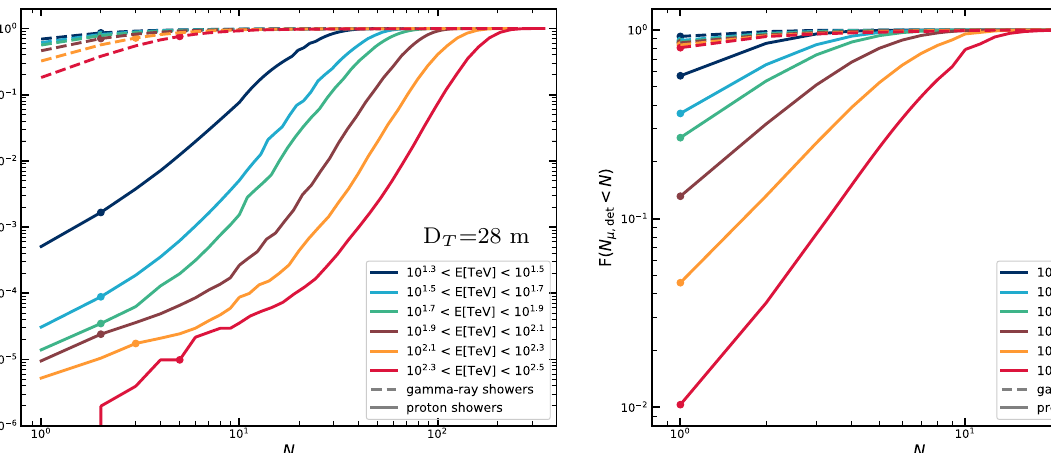
Fig. 7 Cumulative distribution of the number of detectable muons in proton-initiated showers (solid lines) and gamma-ray-initiated showers (dashed lines) for several primary energy ranges. A round marker is